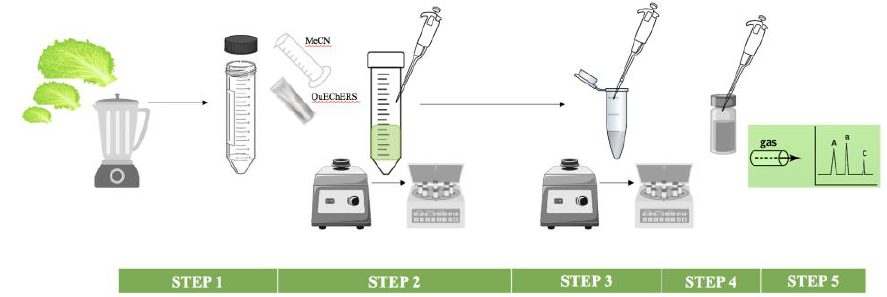
Scheme 1. Schematic illustration of the extraction procedure.